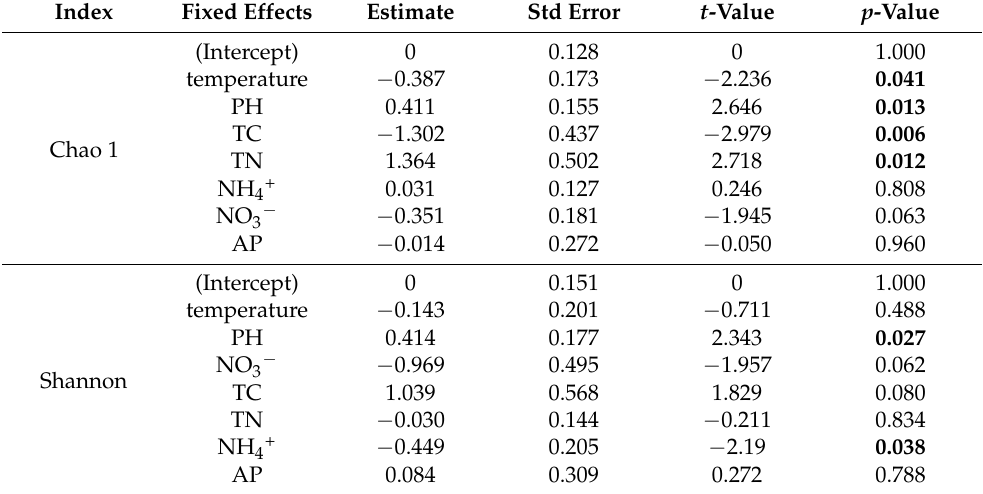
Table 3. Effects of soil variables on bacterial richness (Chao 1) and diversity (Shannon) explored with a linear mixed-effects model. p -values from likelihood ratio tests (df = 25). Significant effects ( p < 0.05) are shown in